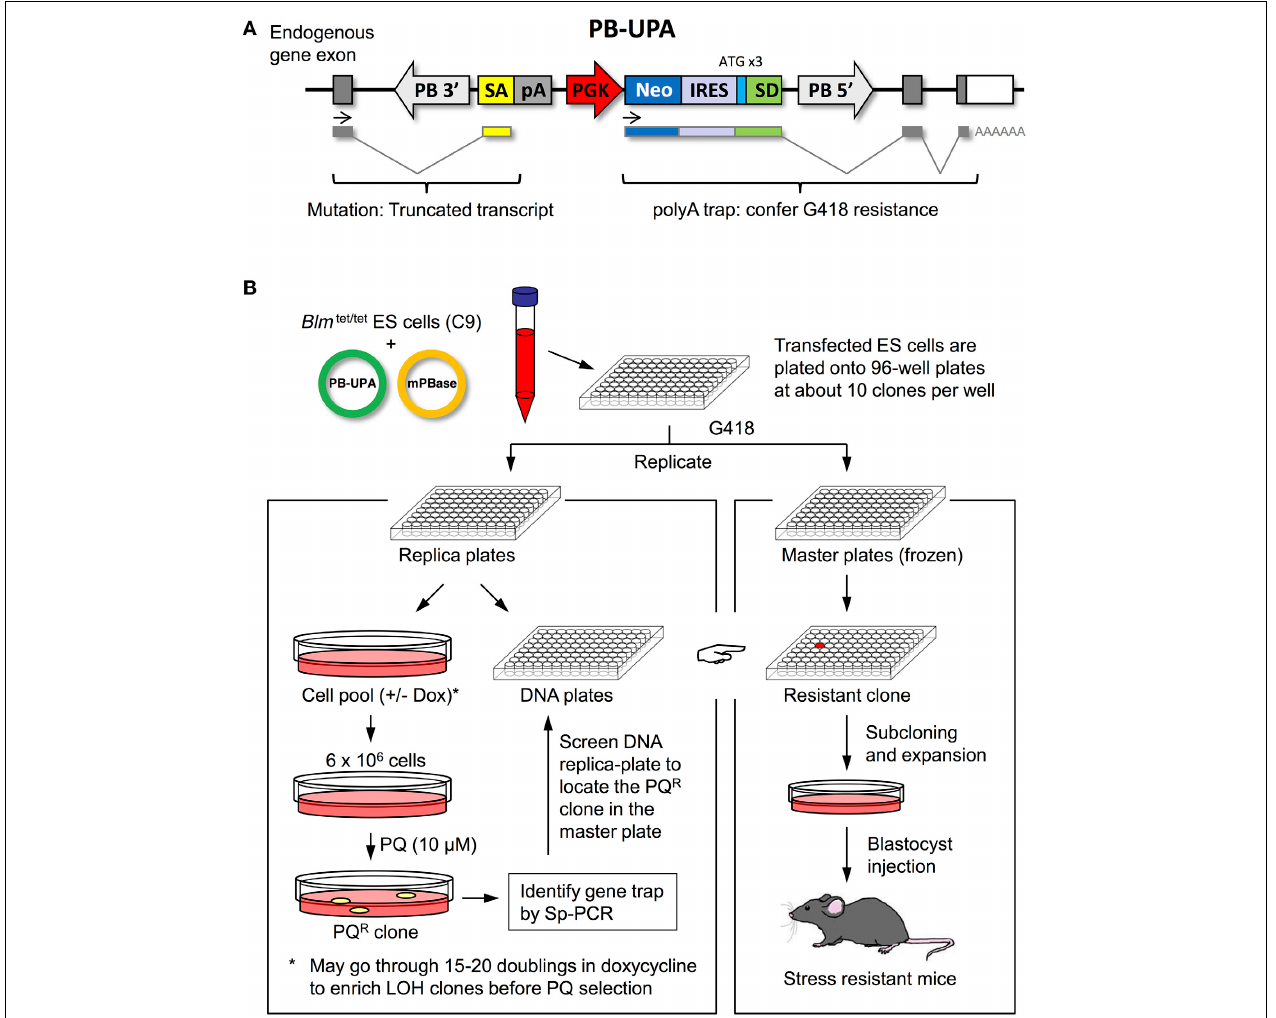
FIGURE 1 | Methods used in ES-cell mutagenesis and selection for stress resistance. (A) Anatomy of the piggyBac (PB)-UPA vector. A UPA Trap vector containing a splice acceptor (SA), the bovine growth hormone poly-adenylate signal (pA), the phosphoglycerate kinase (PGK) promoter, the neomycin phosphotransferase gene (neo), an internal ribosomal entry site (IRES), and a splice donor (SD) with ATG (in 3 different reading frames) was cloned into the piggyBac transposon vector, flanked by the 3 (cid:2) and 5 (cid:2) long terminal repeats (PB 3 (cid:2) and PB 5 (cid:2) ) to yield PB-UPA. Gene-trapping occurs when the PB-UPA inserts into the intron of a gene. The exon upstream of the insertion site splices to the SA of PB-UPA and the transcription will be terminated by the pA. At the same time, the expression of neo, driven by PGK, will be possible when the SD splices to the downstream exons and acquires the endogenous polyA signal from the trapped gene, conferring G418 resistance to the cell and allowing selection of ES cells carrying the PB-UPA vector. (B) Method of mutagenesis in ES cells and selection for